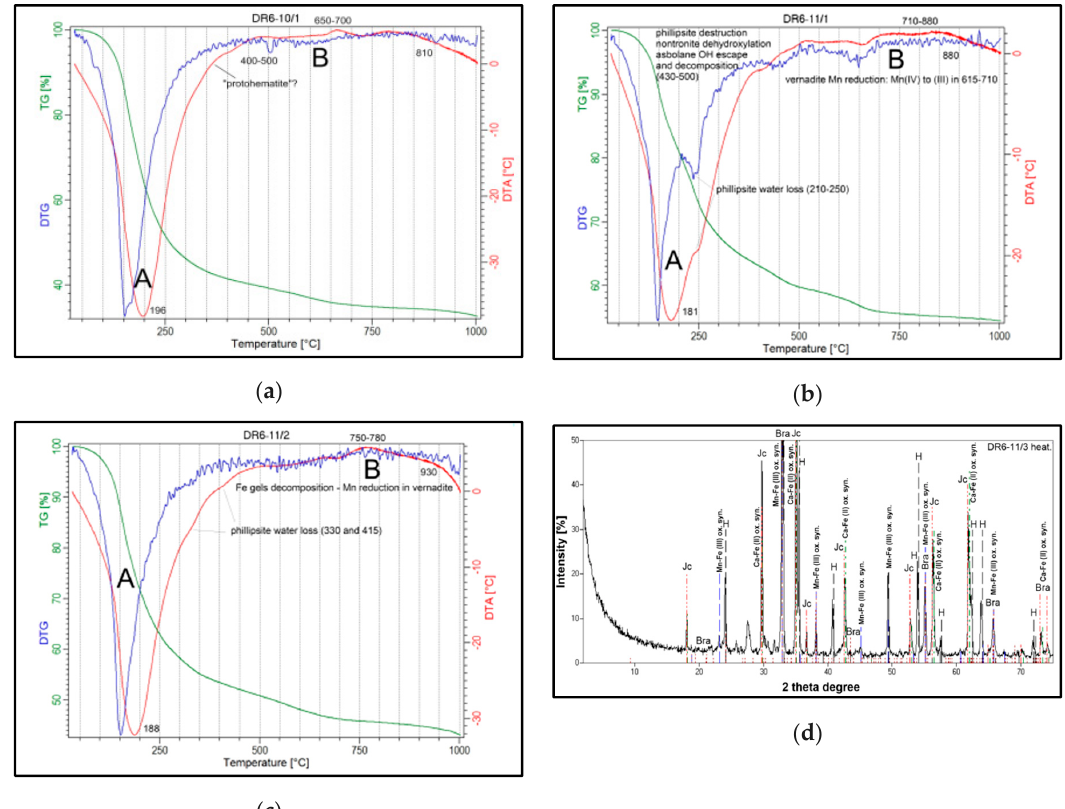
Figure 5. Representative DTA and TGA curves of the bulk crust samples from the DHR: ( a ) DR6-10/1; dehydratation of vernadite and minor iron gels (feroxyhyte-ferrihydrite); B-wide exothermal decomposition of vernadite and Fe-rich gels; manganese reduction in vernadite (3 + to 2 + ); synthesis of the new minerals phases; ( b ) DR6-11/1; A-dehydratation and dehydroxylation of phillipsite, vernadite, asbolane and other phases (hydroxyapatite, nontronite, celadonite), structure destruction in phillipsite and asbolane; nontronite dehydroxylation; B-exothermal decomposition of Fe-gels and Mn reduction in vernadite; low intensive dehydroxylation of phyllosilicates; >880 ◦ C synthesis of the new mineral phases; ( c ) DR6-11/2; A-dehydratation and dehydroxylation of vernadite, asbolane, hydroxyapatite, phillipsite, nontronite and celadonite; carbon dioxide loss in hydroxyapatite; B-exothermal decomposition of Fe-gels and Mn reduction in vernadite; further dehydroxylation of phyllosilicates; >950 ◦ C synthesis of the new mineral phases; ( d ) XRD diffractogram of the heated DR6-11/3 subsample shows presence of synthetic braunite, jacobsite, hematite, Ca-ferrite and Mn-Fe(III)